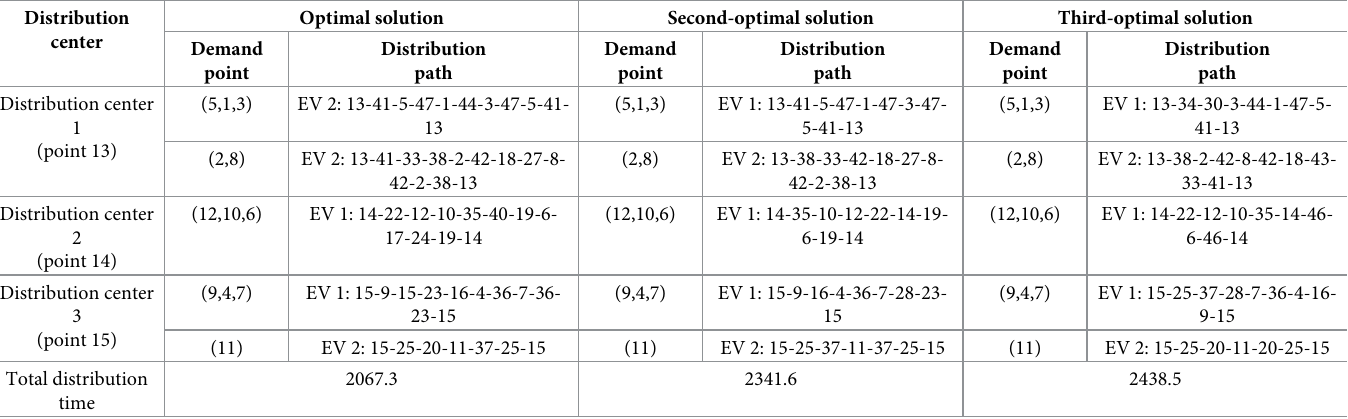
Table 2. Solution set when T = 0 .